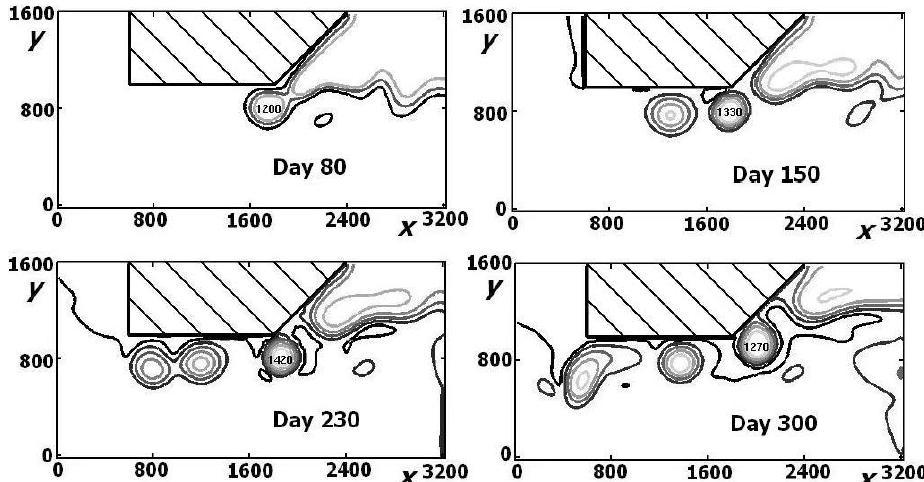
Fig. 6. Upper layer thicknesses for the case of a Concave I coastline with a modest kink (midsize γ ) and a current with high upstream vorticity ( γ =45 ◦ , α = 1, h 0 = 300m, ν = 700m 2 s − 1 , and β = 6 × 10 − 11 m − 1 s − 1 ). The eastern wall is not critically slanted, so rings are formed upstream of the kink. Thicknesses are given in meters, and the x and y scales are in kilometers. This figure, as well as Fig. 7, is given here merely to illustrate the dynamics – both figures are not necessarily associated with either the SIF or NPR, whose numerical runs are displayed in Figs. 9 and 10.